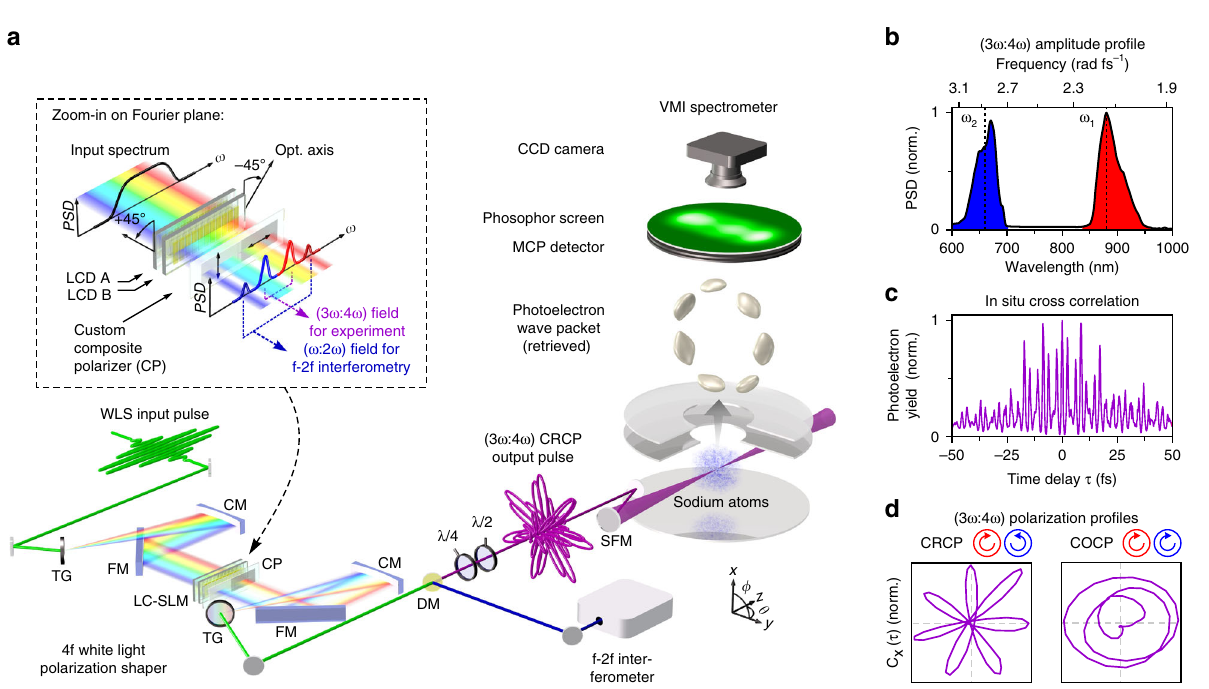
Fig. 1 Experimental setup and pulse characterization. a The experimental setup combines shaper-based generation of (3 ω :4 ω ) BiCEPS pulses and photoelectron tomography using a VMIS. Bichromatic amplitude, phase and polarization modulation is implemented by a 4 f polarization pulse shaper, adapted to the over-octave spanning WLS and equipped with a composite (CP) polarizer in the Fourier plane 9 (see inset). The additional optical elements are: transmission gratings (TGs), cylindrical mirrors (CMs), folding mirrors (FMs) and a quarter wave plate ( λ /4). A multi-chromatic fi eld is extracted from the WLS, consisting of the (3 ω :4 ω ) BiCEPS pulse and an additional ( ω :2 ω ) fi eld for active CEP stabilization. The former is coupled into the VMIS via a spherical focusing mirror (SFM), while the latter is split off the main beam via a dichroic mirror (DM) to seed a single-shot f -2 f interferometer 11 . 2D projections of the released FEWP are detected under various angles by rotating the BiCEPS pulse using a λ /2 wave plate. The 3D FEWP is retrieved by employing tomographic techniques 10 . b Measured amplitude pro fi le of a shaper-generated (3 ω :4 ω ) fi eld. c In situ shaper-based CC trace 9,11 from MPI of Na atoms with (3 ω :4 ω ) PLP pulses. The trace shows the beating of the two colors. From the temporal width of the trace, we derive a pulse duration of Δ τ CC trajectory of the CRCP fi eld reveals a propeller-type pro fi le with sevenfold rotational symmetry (left), while the trajectory of the COCP fi eld yields a heart-shaped pro fi le (right). For clarity, only the central beating cycle is